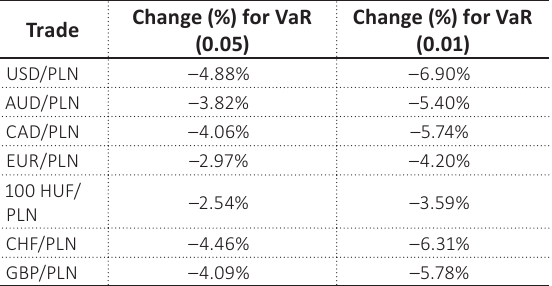
Table 4. Investment risk in traditional currencies expressed in terms of value at risk in relative terms over 10